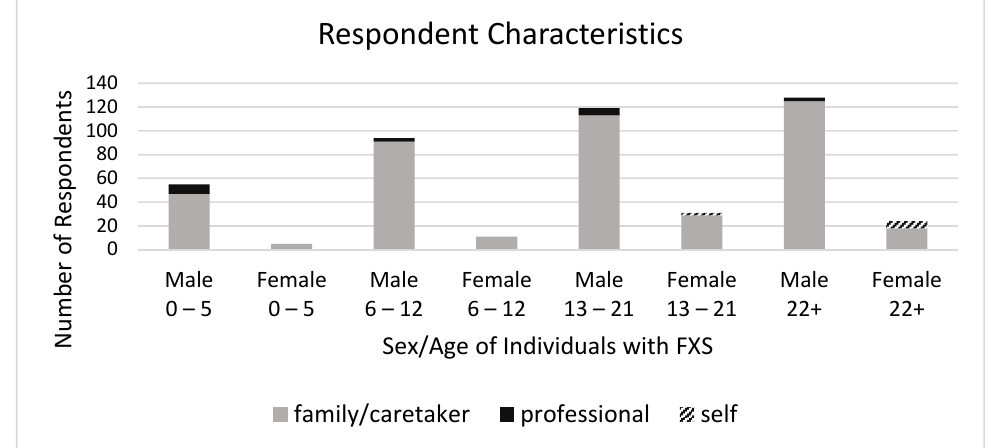
Figure 1. Survey respondent characteristics. FXS: Fragile X syndrome.